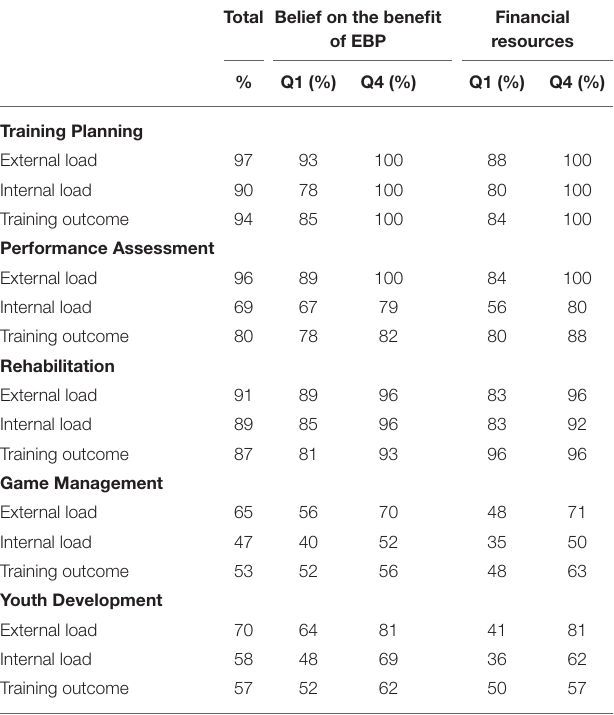
Proportions are presented for the total sample and for quartile 1 (Q1) and quartile 4 (Q4) for both club belief on the benefit of evidence-based practice (EBP) and club financial resources.